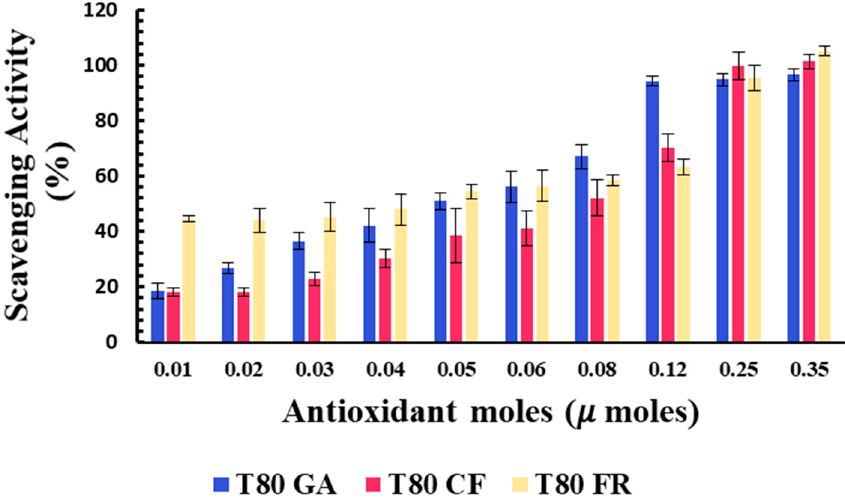
Figure 3. Antioxidant activity of T80-GA (blue), T80-CF (red), and T80-FR (yellow) against DPPH• expressed as a percentage of radical scavenging activity versus antioxidant µmoles grafted onto niosomes’ surfaces. Results represent the mean ± S.D. of three independent experiments performed with triplicate measurements.